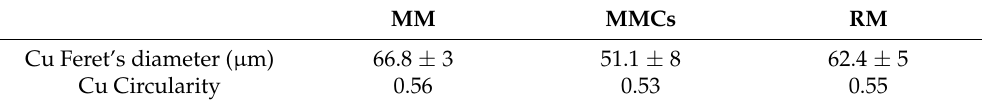
Table 3. Size and shape measurements of Cu phase within the metallic